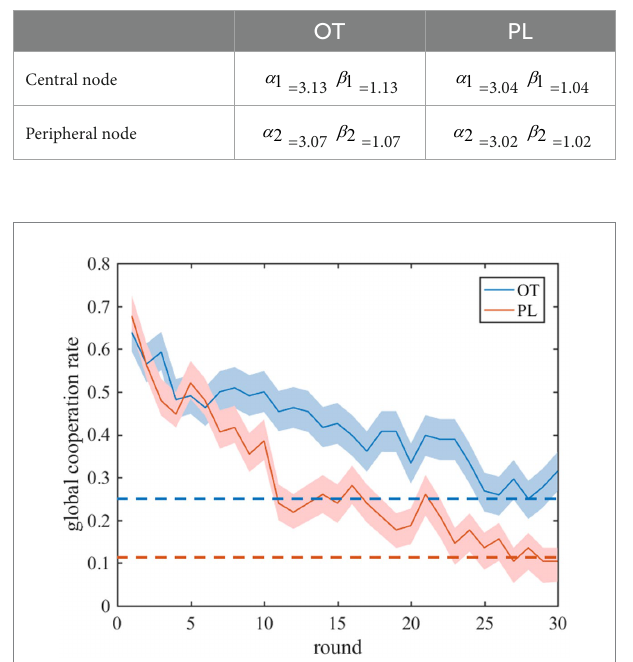
TABLE 8 Estimated values of α 1 , α 2 , β 1 , and β 2 in OT and PL groups.